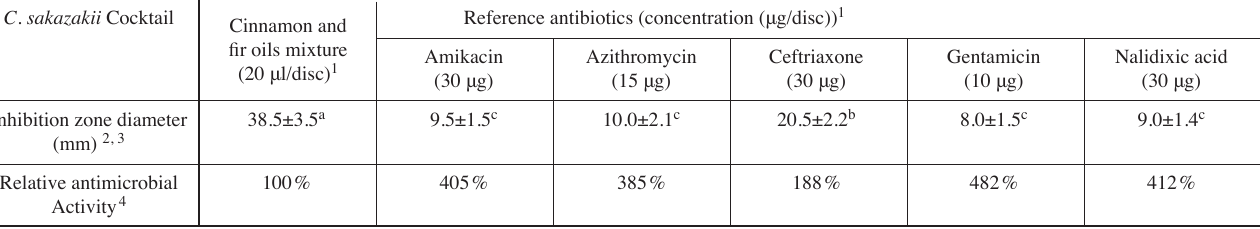
Tab. 3: Relative antimicrobial activity for combination of cinnamon and fir oils (20 μl/disc) to selected antibiotics against a 4 strains C. sakazakii cocktail using disc diffusion method at 37